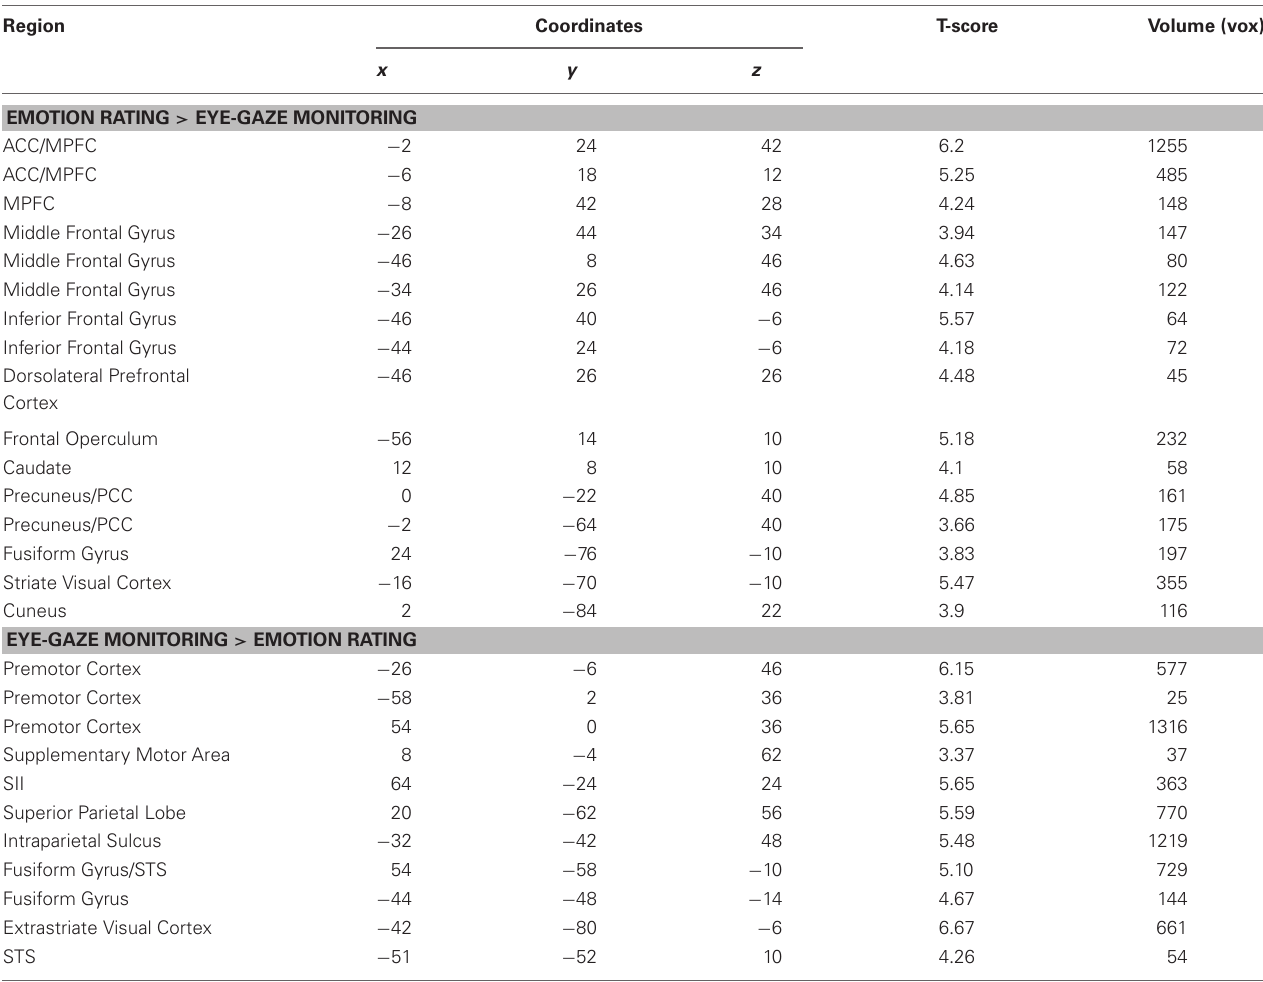
Table 1 | Main effects of